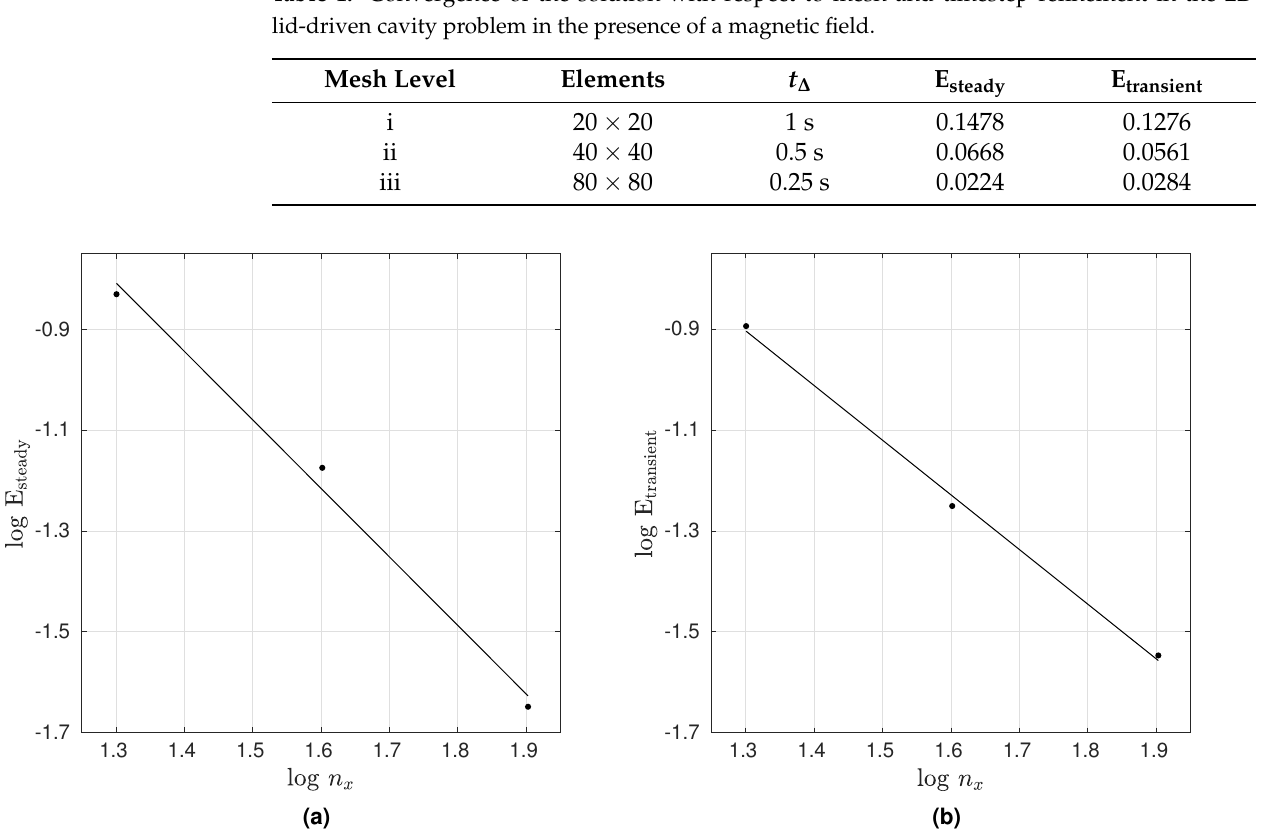
Figure 2. ( a ) Convergence of the steady-state solution with respect to mesh refinement. ( b ) Conver- gence of the transient solution with respect to mesh and timestep